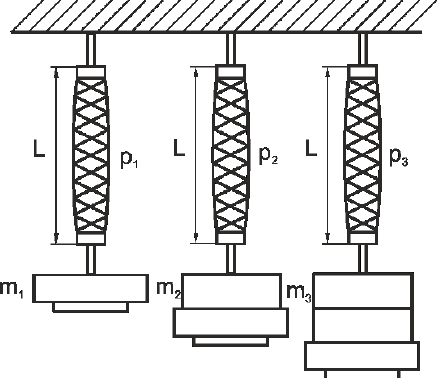
Fig. 9. The principle of determining the isometric characteristics of the pneumatic artificial muscle